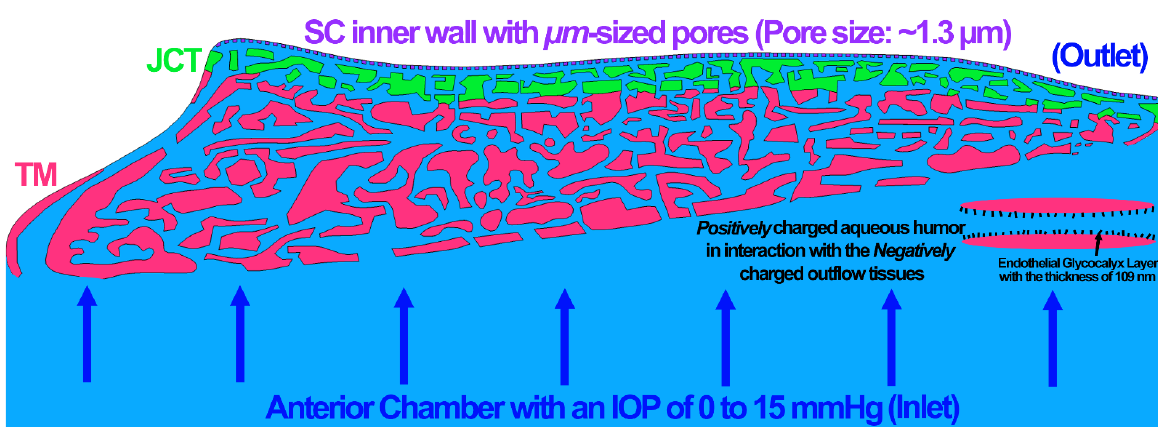
Figure 1. The electrical – fluid – structure interaction model of the TM, with adjacent SC (~2.2 µm) and JCT (~14 µm), and aqueous humor. The µm-sized pores with the average size of ~1.3 µm and the density of 835 pores/mm 2 were distributed in the SC inner wall.